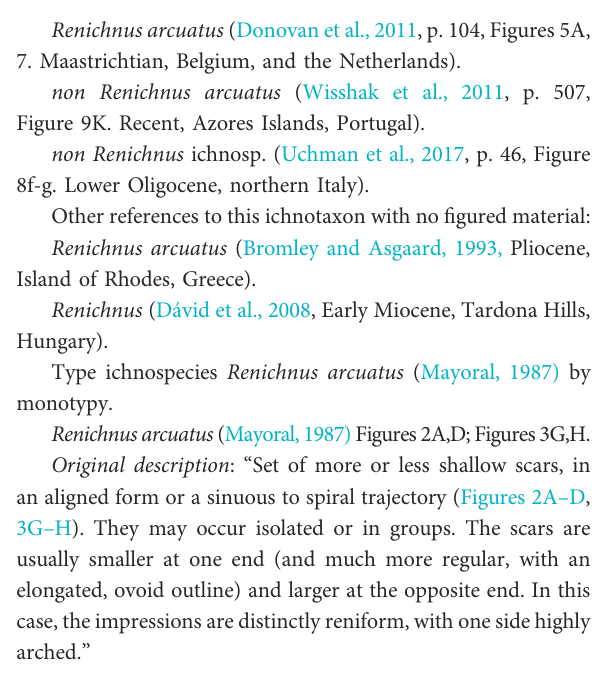
Figure 9K. Recent, Azores Islands, Portugal).